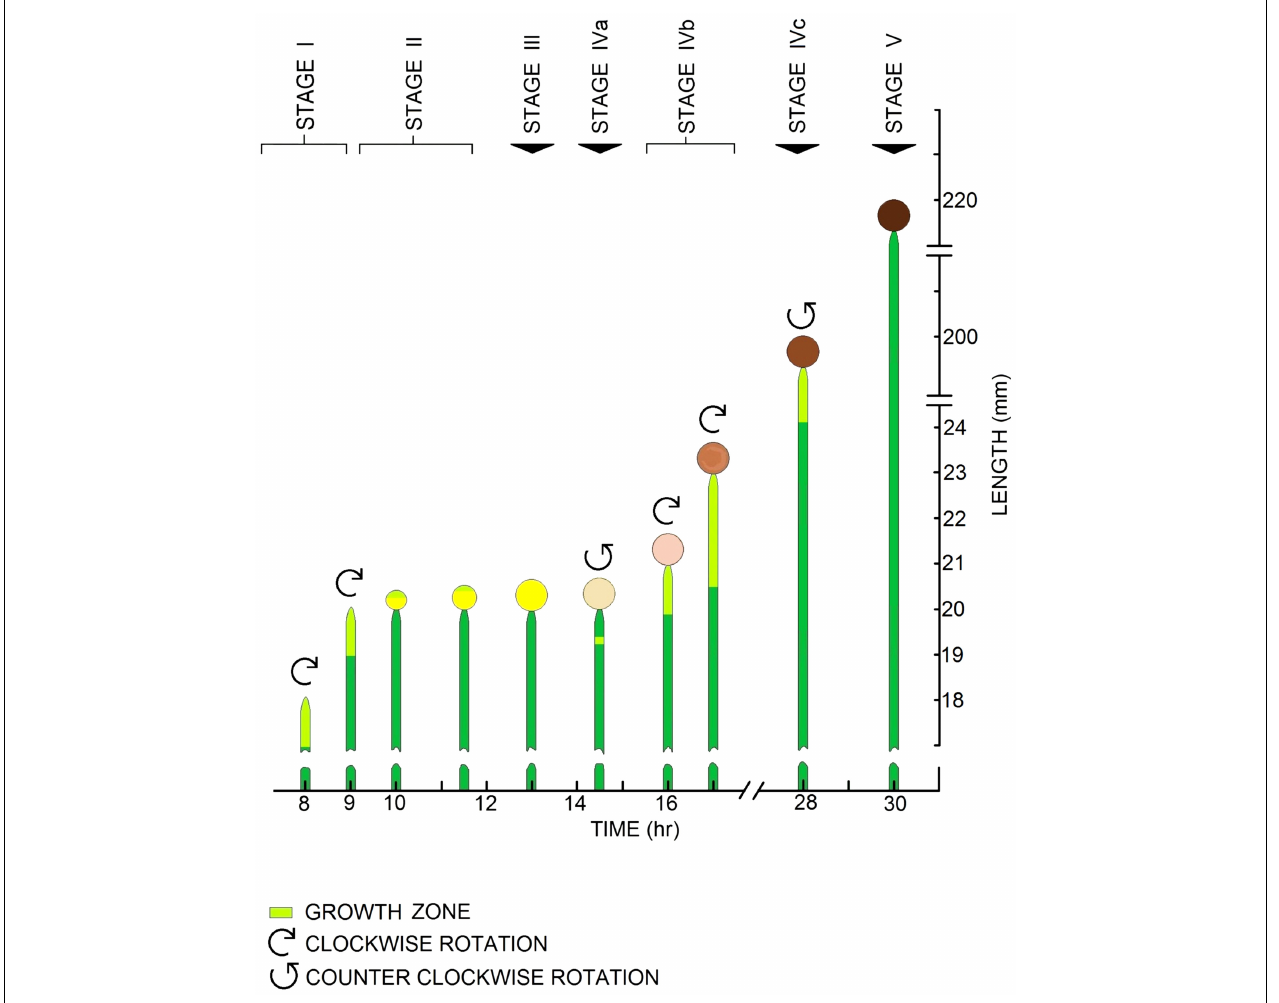
rotation growth (right-handed helical growth) in a short growth zone located approximately 0.6mm below the sporangium.The sporangium begins to darken and elongation growth, rotation growth, and growth zone length continue to increase during this stage.The right-handed helical growth continues for approximately 1h before the rotation rate gradually decreases to zero and clockwise rotation begins. Stage IVb begins with the initiation of left-handed helical growth. Stage IVb exhibits nearly constant elongation and rotation growth rates for many hours. Stage IVc is initiated by counter-clockwise rotation and right-handed helical growth.Typically, this is a very old sporangiophore. StageV is the last stage and does not exhibit visible